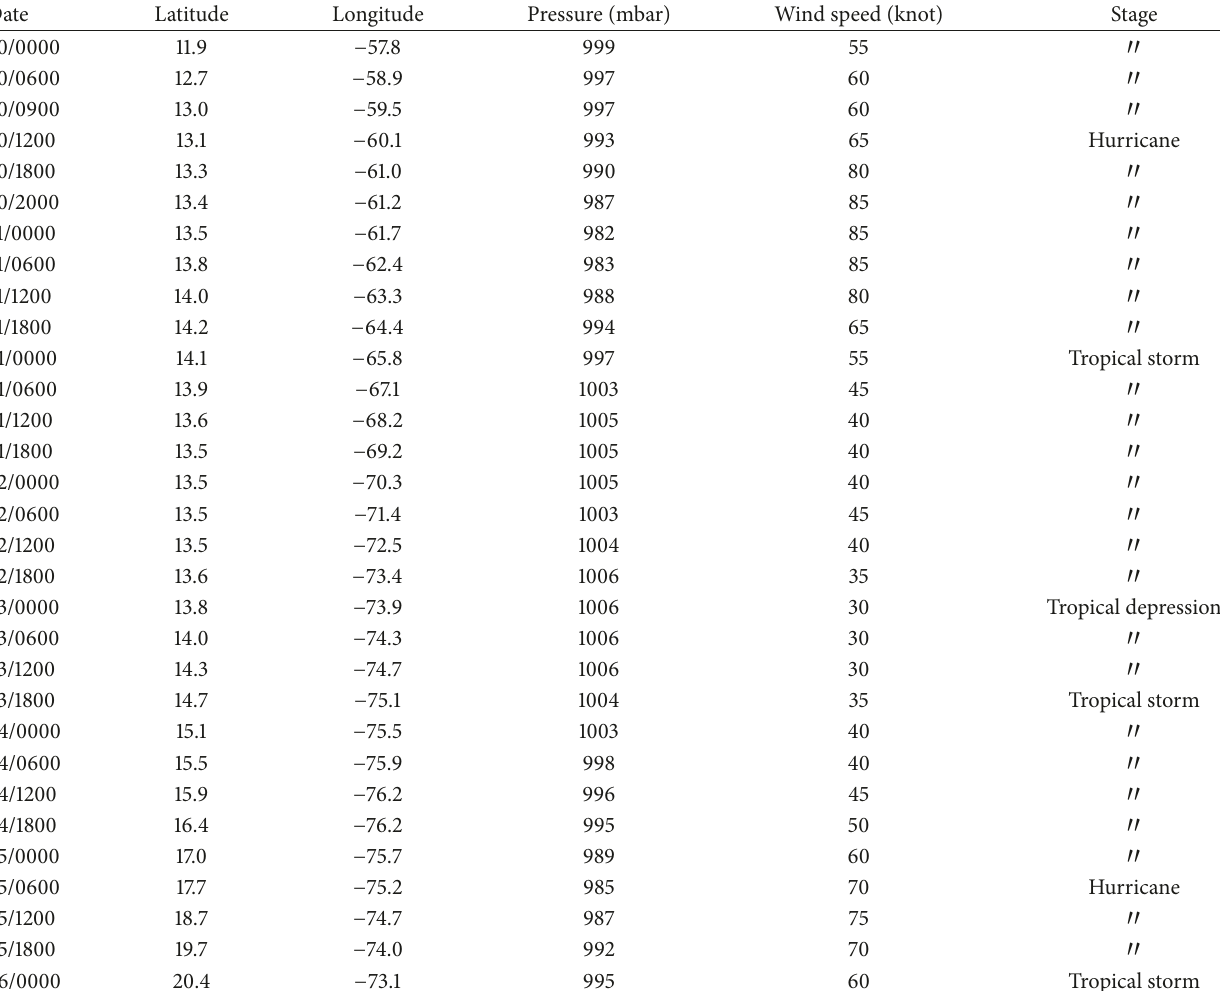
Table 1: Observed data of position, minimum SLP, and maximum surface wind for Hurricane Tomas.